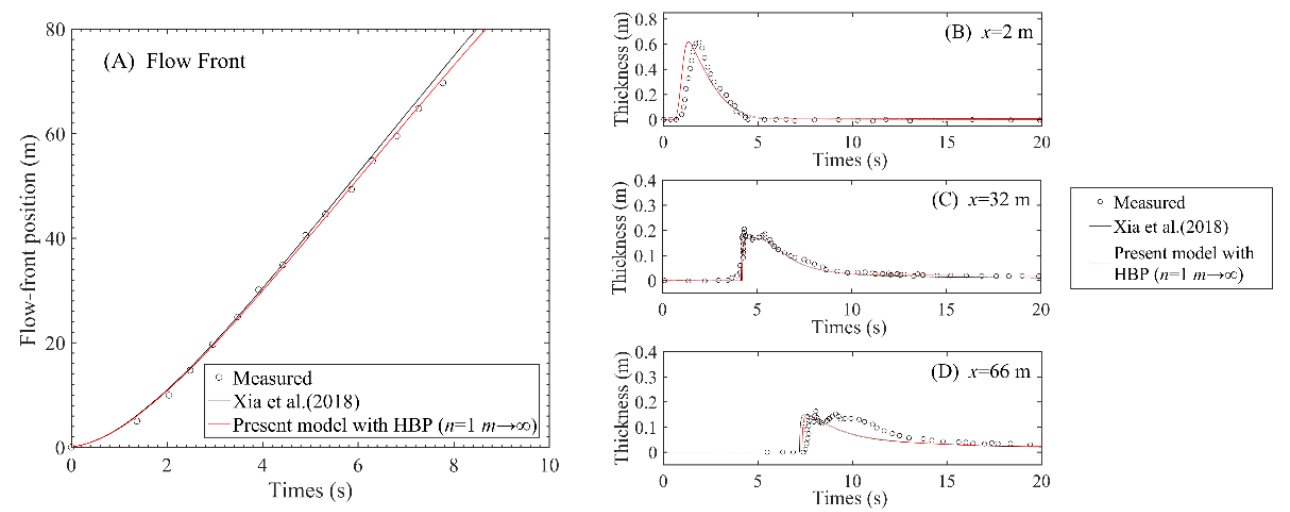
Figure 2. Computed results by Xia et al. (2018) [7] and present model with HBP model. ( A ) Flow front tracking; ( B ) flow thickness at x = 2 m; ( C ) flow thickness at x = 32 m; ( D ) flow thickness at x = 66 m.